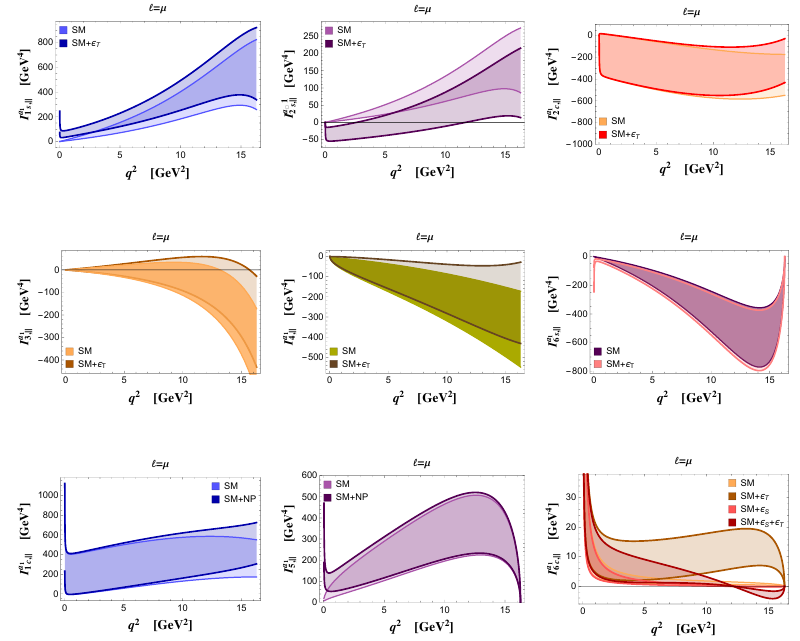
( q 2 ) in SM and NP (at the benchmark point) for ¯ B → Figure 14. Angular coefficient functions I a 1 i a 1 ( ρ (cid:107) π ) µ − ¯ ν µ using the form factors in Reference [60]. The band widths for SM and NP, with colors indicated in each plot, are due to the form factor uncertainty.